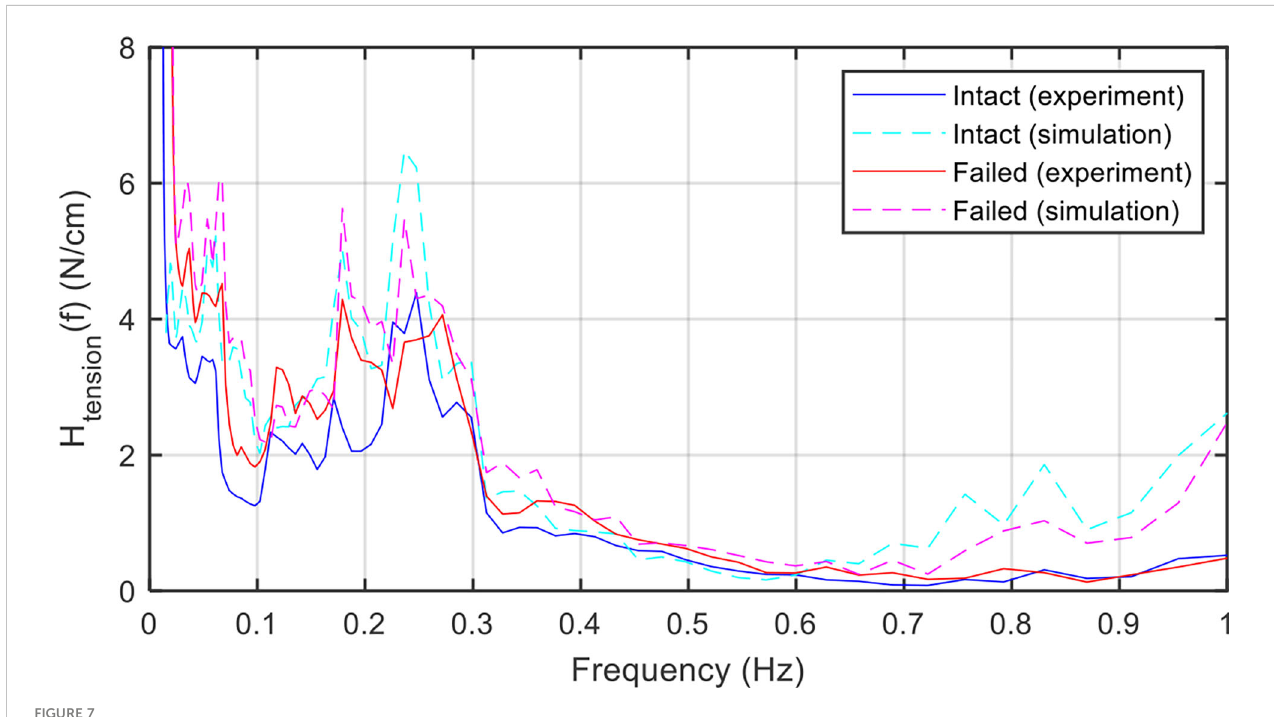
FIGURE 7 The transfer function of the mooring tension in Line